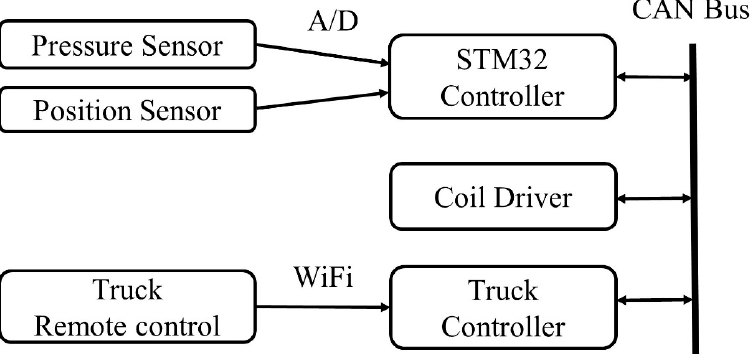
Figure 13. Electronic control system of the test rig.